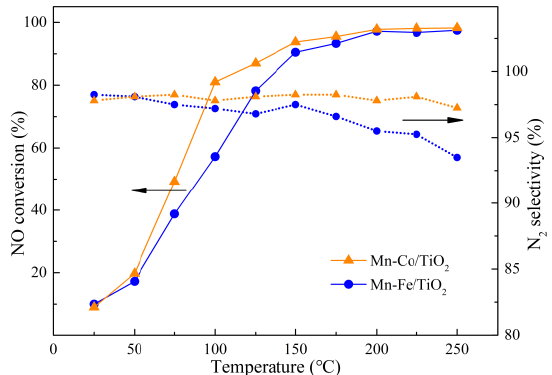
Figure 7. Catalytic performance of Mn − Co/TiO 2 and Mn − Fe/TiO 2 nanocatsalysts.